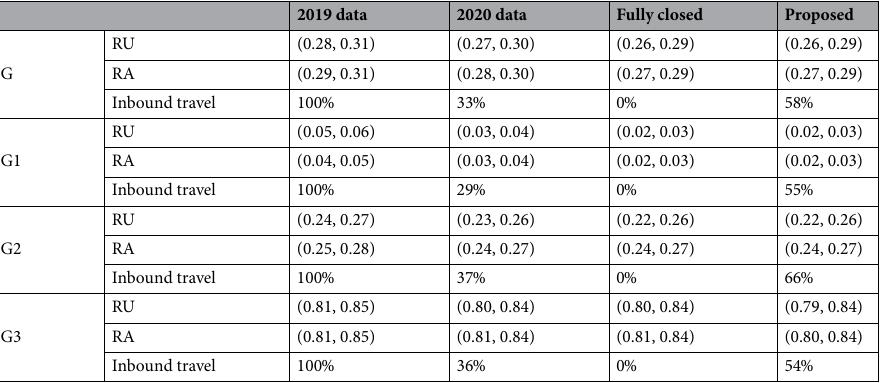
Table 3. Results for effectiveness of travel policy coordination for empirical data. Shown are 2.5th and 97.5th percentiles of relative change in the pandemic situation and percentages of inbound travelers from different groups of countries for different travel regulation scenarios. G denotes all countries; G1, G2, and G3 denotes countries in Group 1, 2, and 3, respectively; RU is the relative change in the number of cases (including detected and undetected), and RA is the relative change in the number of cases that were